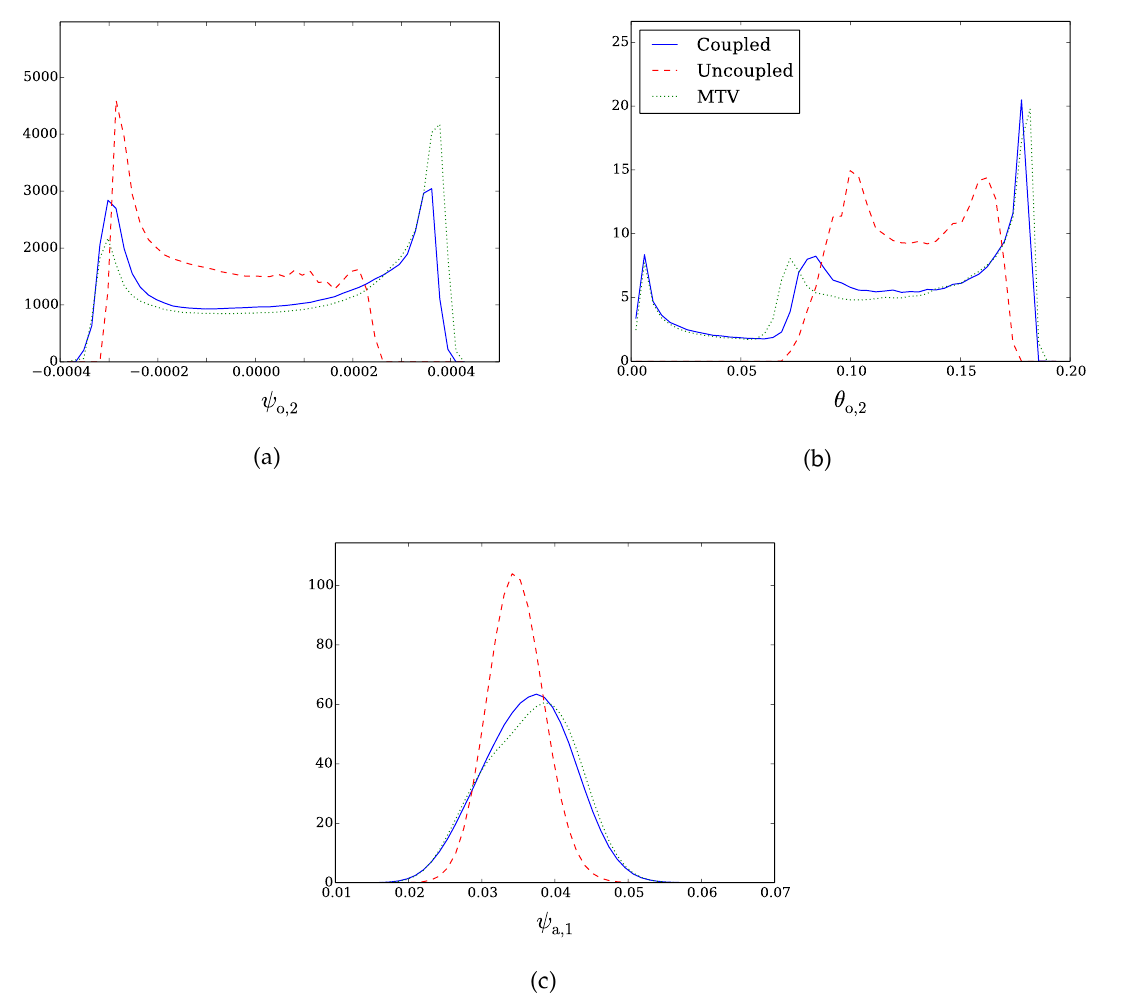
Figure 3. Probability density functions (PDFs) of the dominant variables of the system dynamics as in Fig. 2, but for the wavenumber 2 parameterization and with the parameter set DDV2016. The WL parameterization results are not shown as it is unstable and